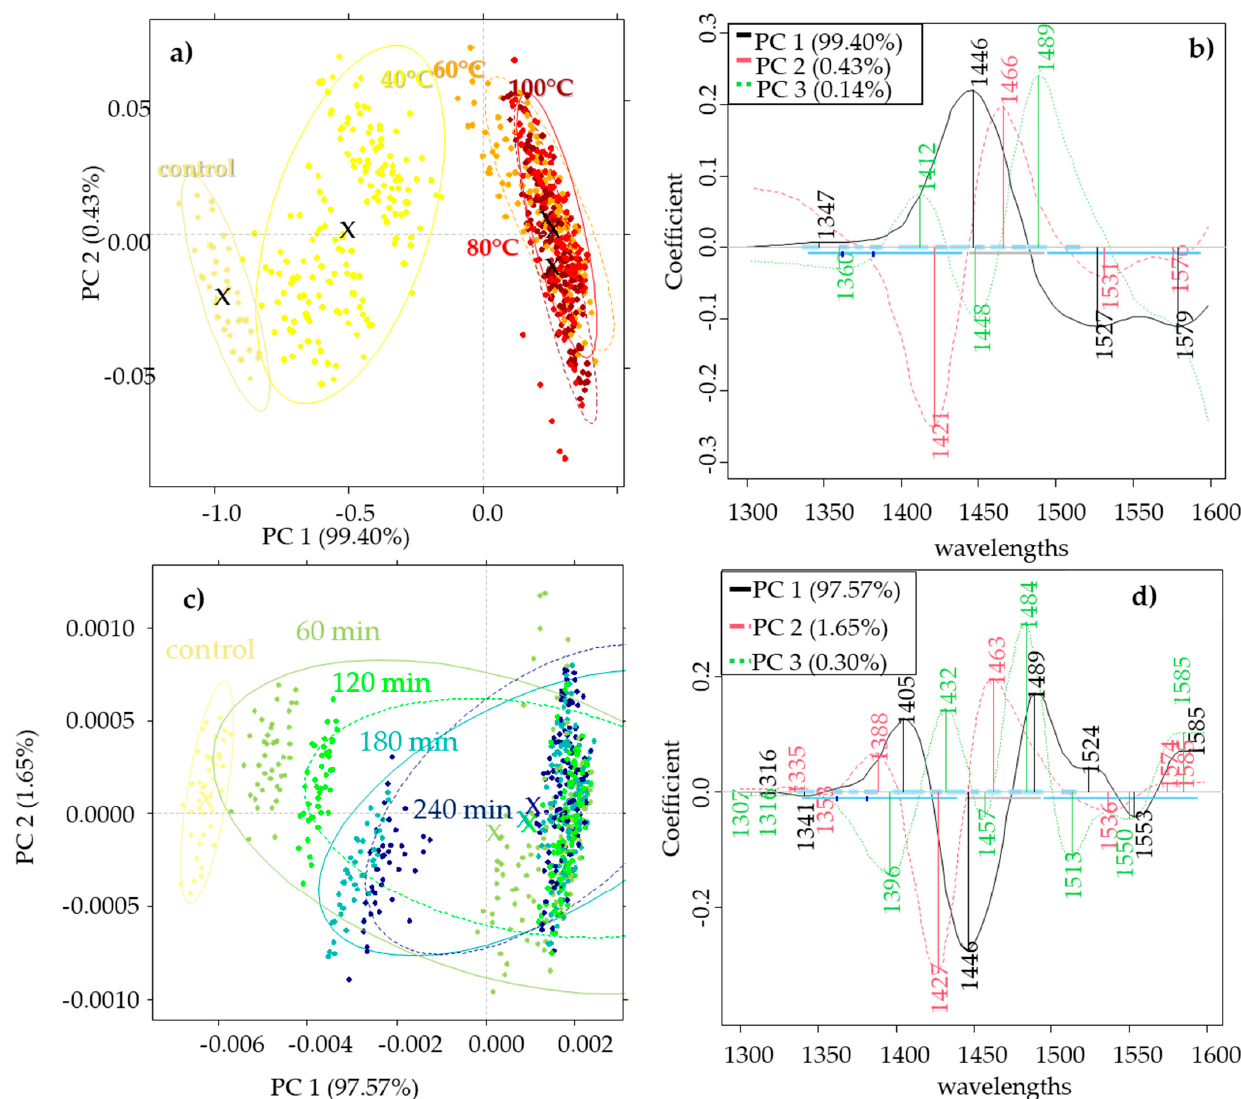
Figure 2. Principal component analysis of the control and heat-treated sunflower honeys: ( a ) PCA score plot for temperature pattern visualization with a Savitzky–Golay smoothing (window size 13) and SNV pretreatment; ( b ) the respective PCA loading plot; ( c ) PCA score plot for the time pattern visualization with a Savitzky–Golay smoothing (window size 13) and Savitzky–Golay 2nd derivative (window size 13, 2nd order derivative) pretreatment; ( d ) the respective PCA loading plot.